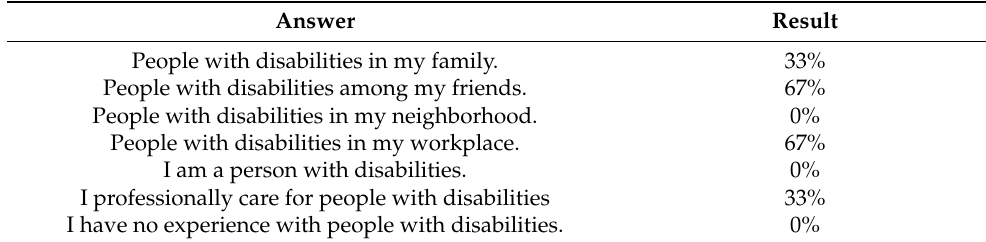
Result Average staff number